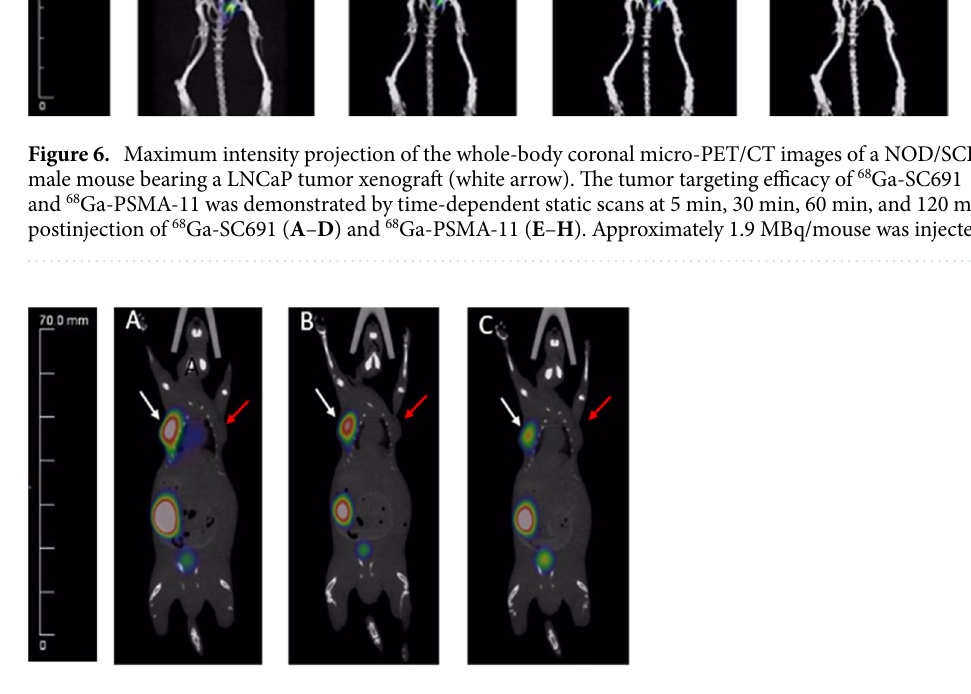
Figure 7. Whole-body coronal micro-PET/CT images of a NOD/SCID male mouse bearing a LNCaP tumor xenograft in PC-3 and LNCaP inoculated xenografts (LNCaP on the left with a white arrow, PC-3 on the right with a red arrow) postinjection of 68 Ga-SC691: 30 min ( A ), 60 min ( B ), 120 min ( C